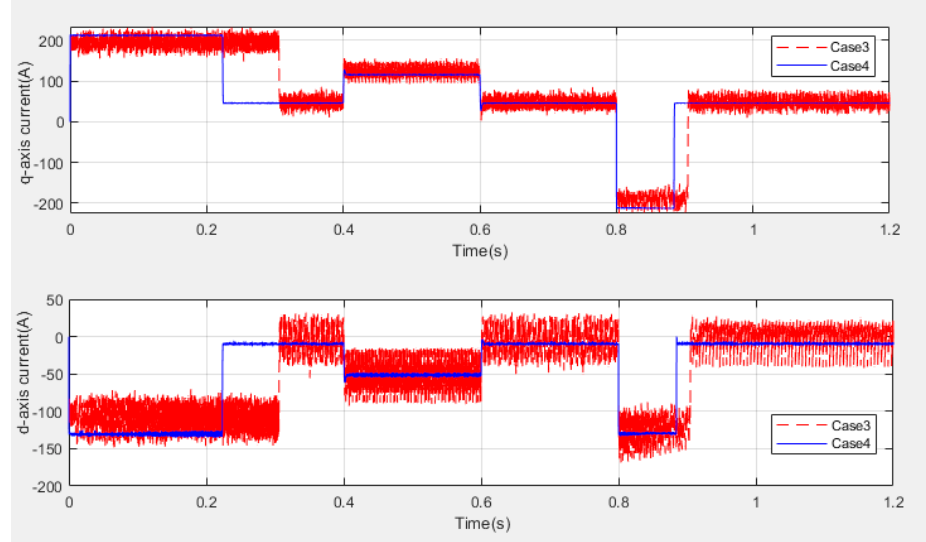
Figure 7. The dq-axis current response in Case 3 and Case 4.